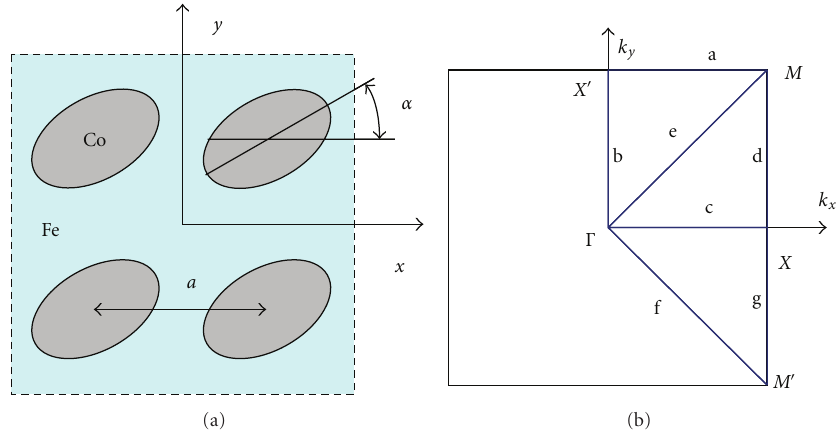
Figure 1: (a) Schematic view of the 2D MC under consideration, section in the plane of periodicity. (b) High-symmetry line over the 2D Brillouin zone for ellipses arranged in a square lattice.